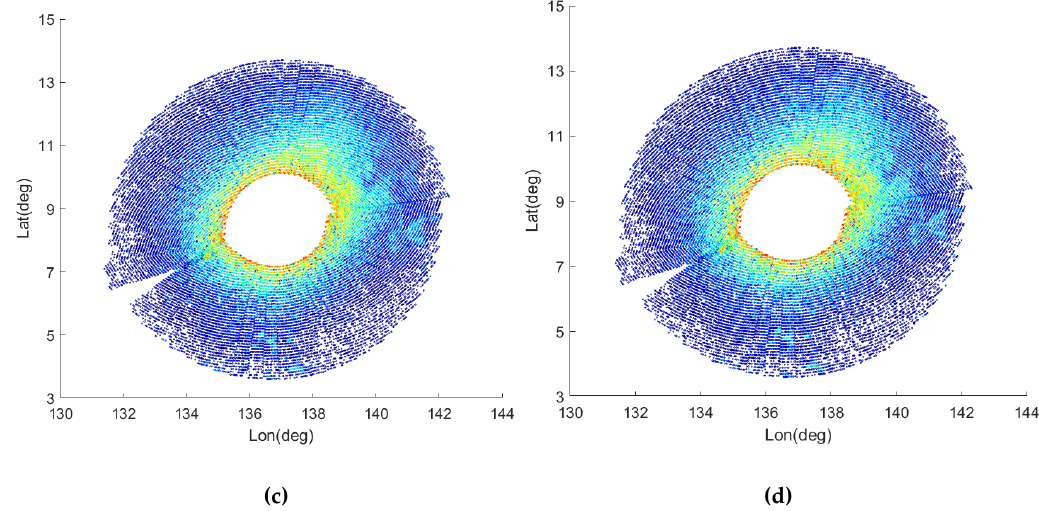
Figure 6. A randomly selected rotating circle of observations. ( a )–( d ) are labelled in the same order as Figure 5. Color indicates NRCS values in dB and is of the same scale of that in Figure 5.